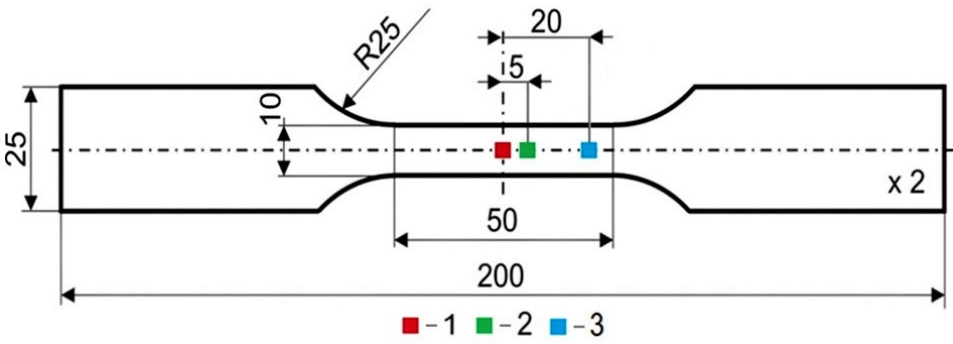
Figure 1. Tested specimen.